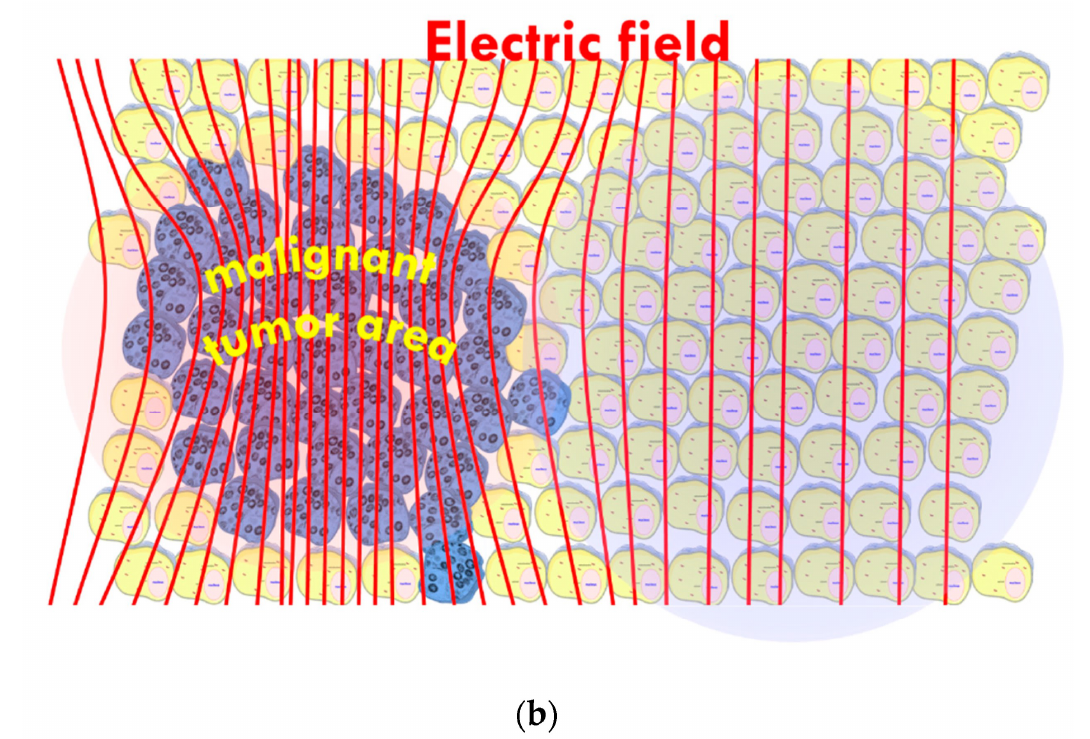
Figure 1. Schematic illustration of the current focus using impedance selection: ( a ) the microscopic illusion of an increase in absorbed energy by the malignant cell compared to the healthy cell, and ( b ) macroscopic illustration of the energy flowing more easily through malignant versus healthy tissue.